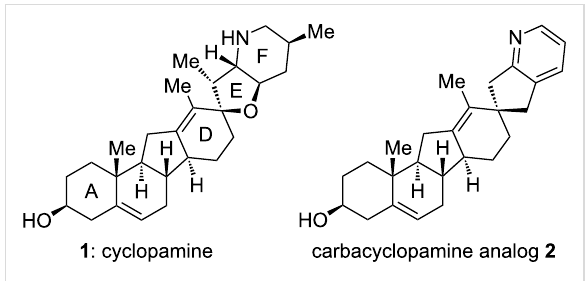
Figure 1: Structures of cyclopamine ( 1 ) and carbacyclopamine analog 2 .